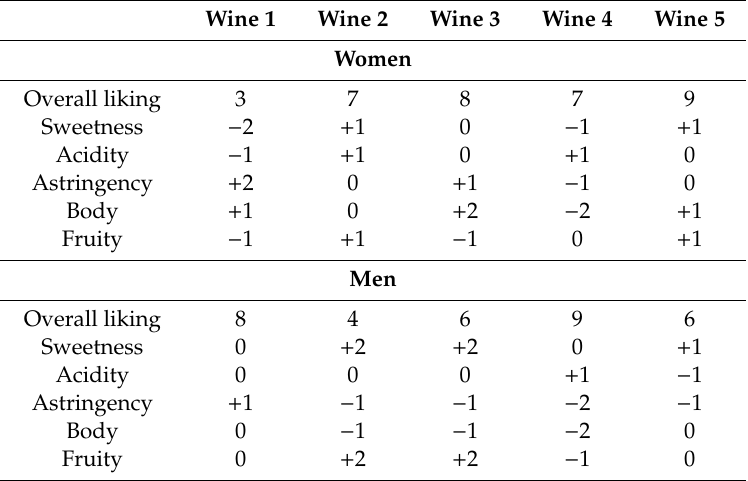
Table 2. Simulated average rating for experiment